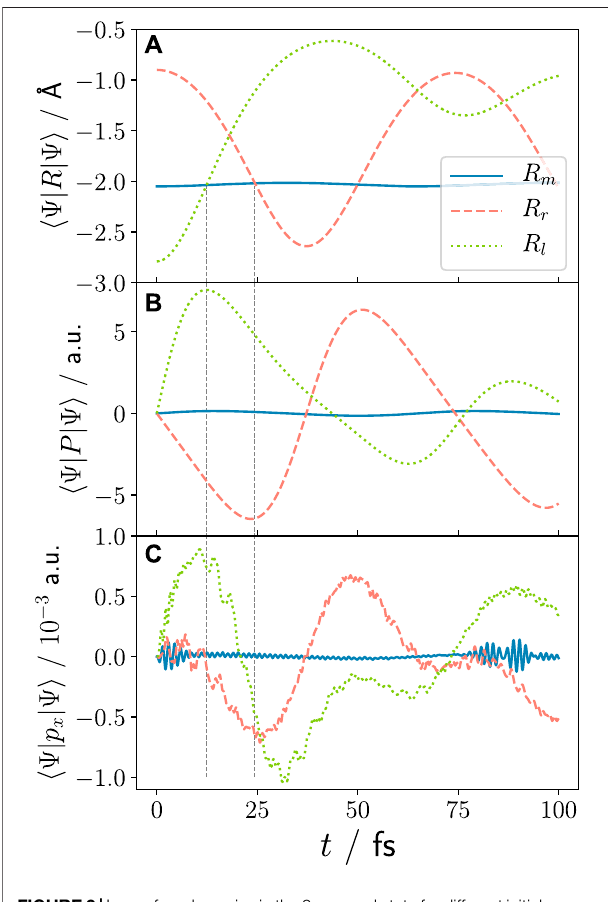
FIGURE2| Laser-freedynamicsinthe2egroundstatefordifferentinitial wave functions (see Eq. 7 ): R m for starting in equilibrium position R 0, m = − 2.05 Å (blue), R l and R r for starting in non-equilibrium positions R 0, l = − 2.79 Å (green) and R 0, r = − 0.90 Å (red), respectively. (A) Nuclear coordinate expectation values, (B) nuclear momentum expectation values, and (C) electron momentum expectation values. The vertical dashed lines indicate the time when the nuclear wave packets reach the equilibrium position. This corresponds to the time of maximum nuclear and electron momentum, and the times around which the XUV pulse is centred in Subsection 3.2 and